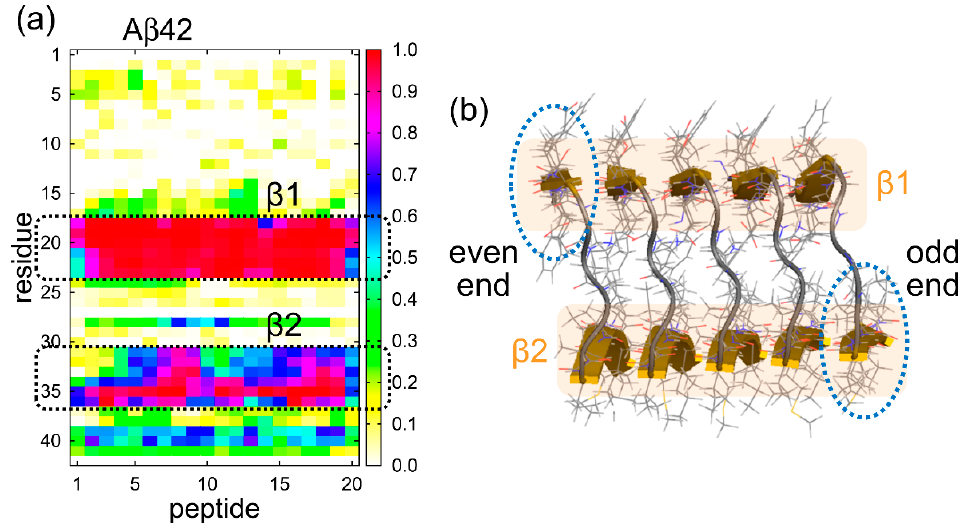
Figure 12. ( a ) The probability that each amino acid residue in each A β peptide has a parallel intermolecular β -sheet structure. ( b ) The A β amyloid fibril structure revealed by NMR experiments (PDB: 2BEG) [11]. The solvent-exposed β -strands at the even and odd ends are indicated by ellipses. Reprinted with permission from Ref. [72]. Copyright 2016 Springer Nature.